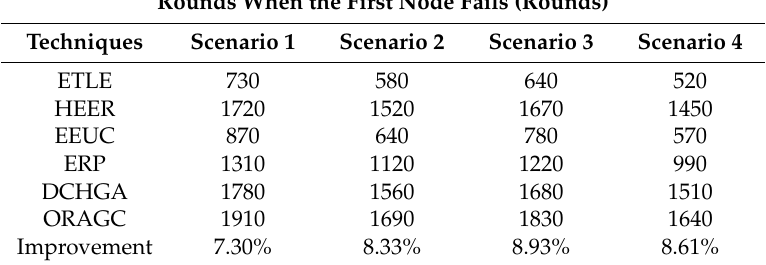
Table 2. Running rounds when the first node fails of six algorithms in four different scenarios, and the improvement is given.